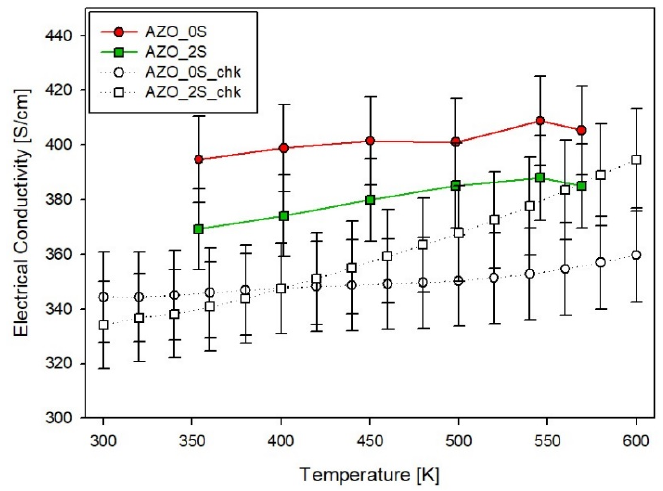
Figure C1. Electrical conductivity plotted vs. temperature of AZO_0S and AZO_2S obtained with two different setups. Filled symbols are the same as those reported in the plots in the main text, while the open symbols “chk” were obtained with another device.